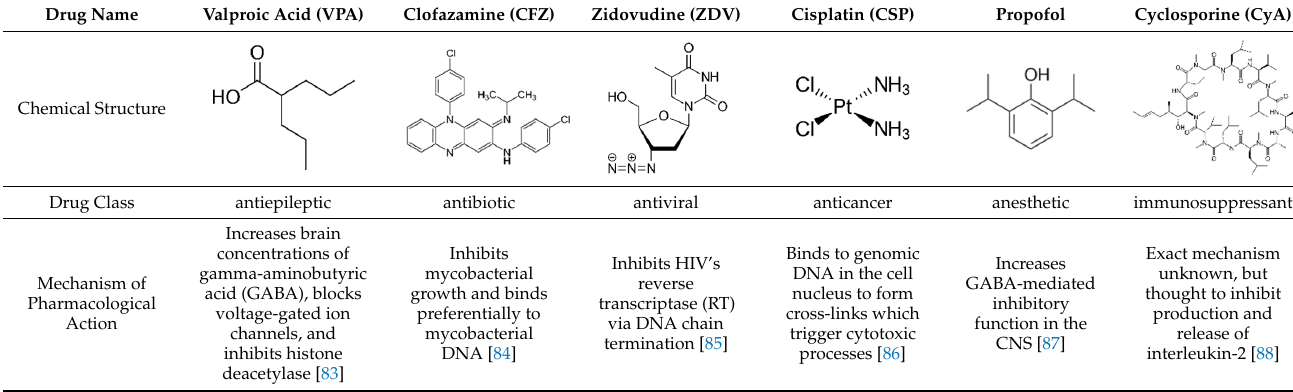
Table 2. Examples of drugs known to cause alterations in mitochondrial metabolic function.